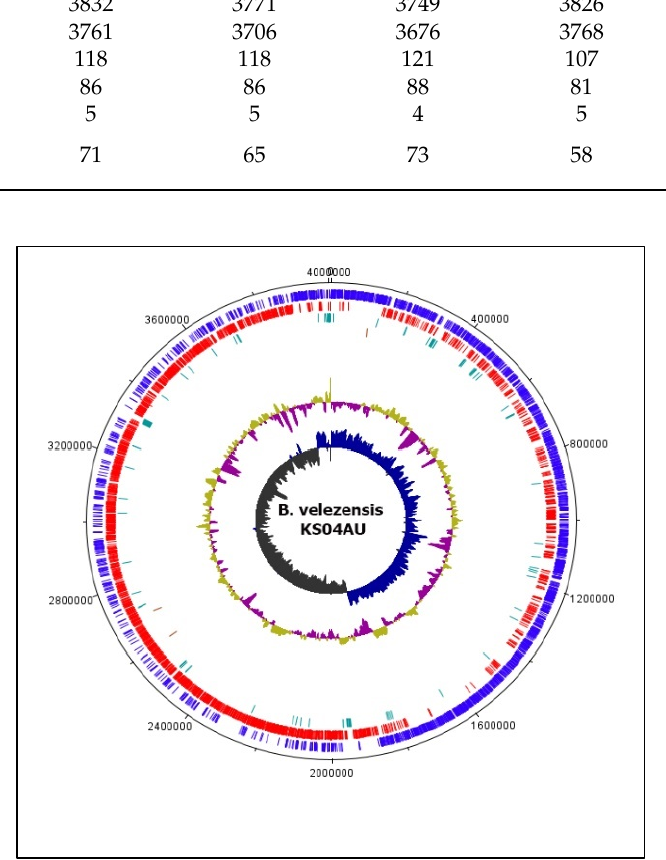
Figure 1. Draft genome of B. velezensis KS04AU. Blue circle—CDS on the plus strand, red circle—CDS on the minus strand, black circle is GC-skew plot (dark blue portion—GC-skew positive, olive-purple portion—GC-skew negative). Table 2. Comparative genomic features of B. velezensis KS04AU with closest-related strain.